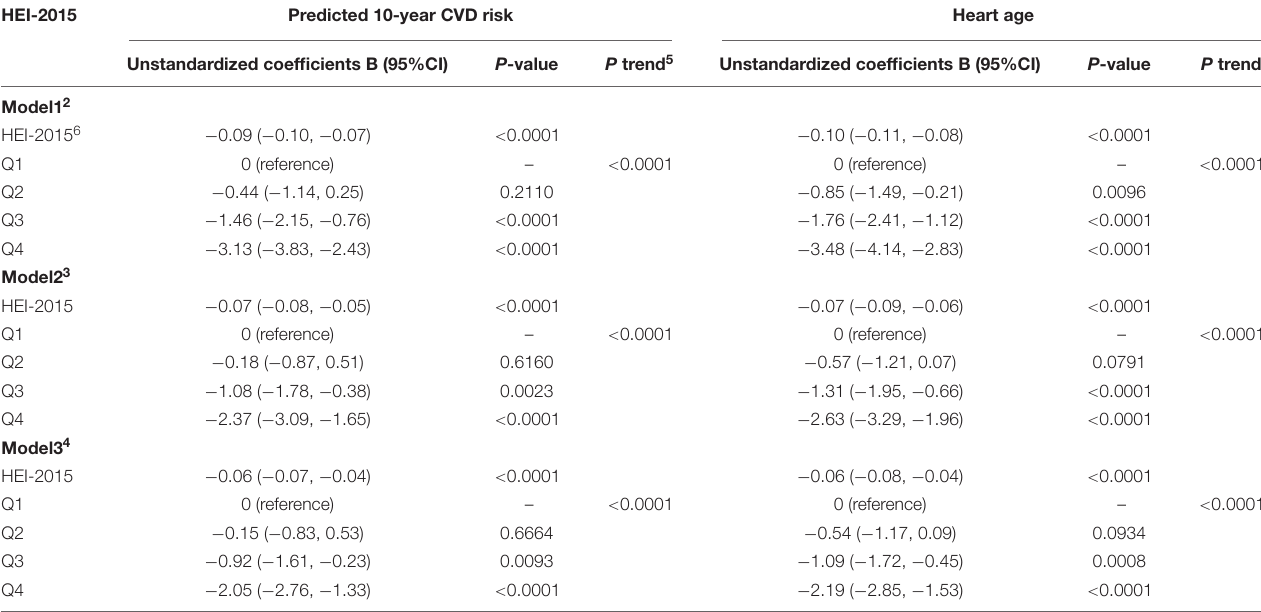
TABLE 2 | Regression coefficients and 95% confidence intervals of HEI-2015 for 10-year CVD risk and heart age.